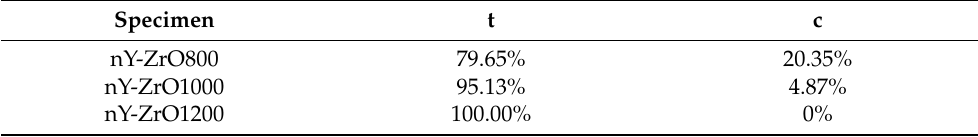
Table 1. Content of tetragonal (t) and cubic (c) crystalline phases in wt% sintered